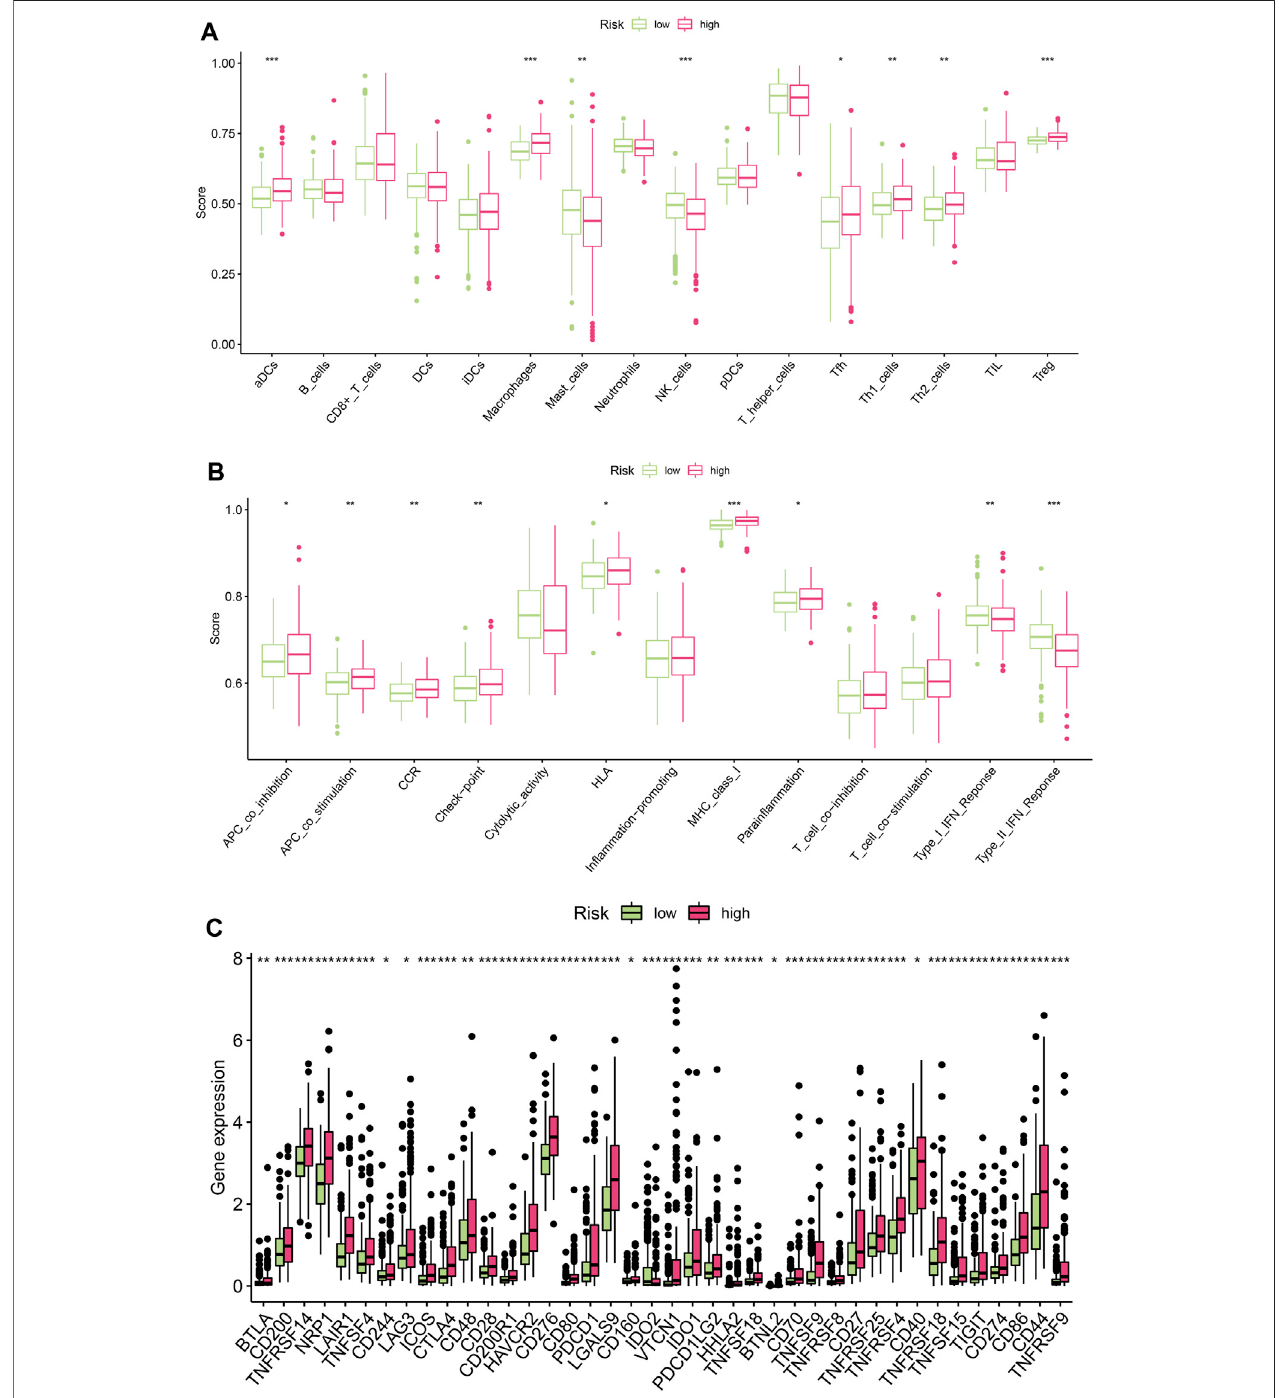
FIGURE 5 | Analysis of immune microenvironment. (A) Differences in levels of immune cell in fi ltration between the high-risk and low-risk groups(* p < 0.05, ** p < 0.01, *** p < 0.001) (B) Differences in the activation of various immune functions between the high-risk and low-risk groups (* p < 0.05, ** p < 0.01, *** p < 0.001) (C) Differences in the expression of immune checkpoint genes between the high-risk and low-risk groups. (* p < 0.05, ** p < 0.01, *** p < 0.001).